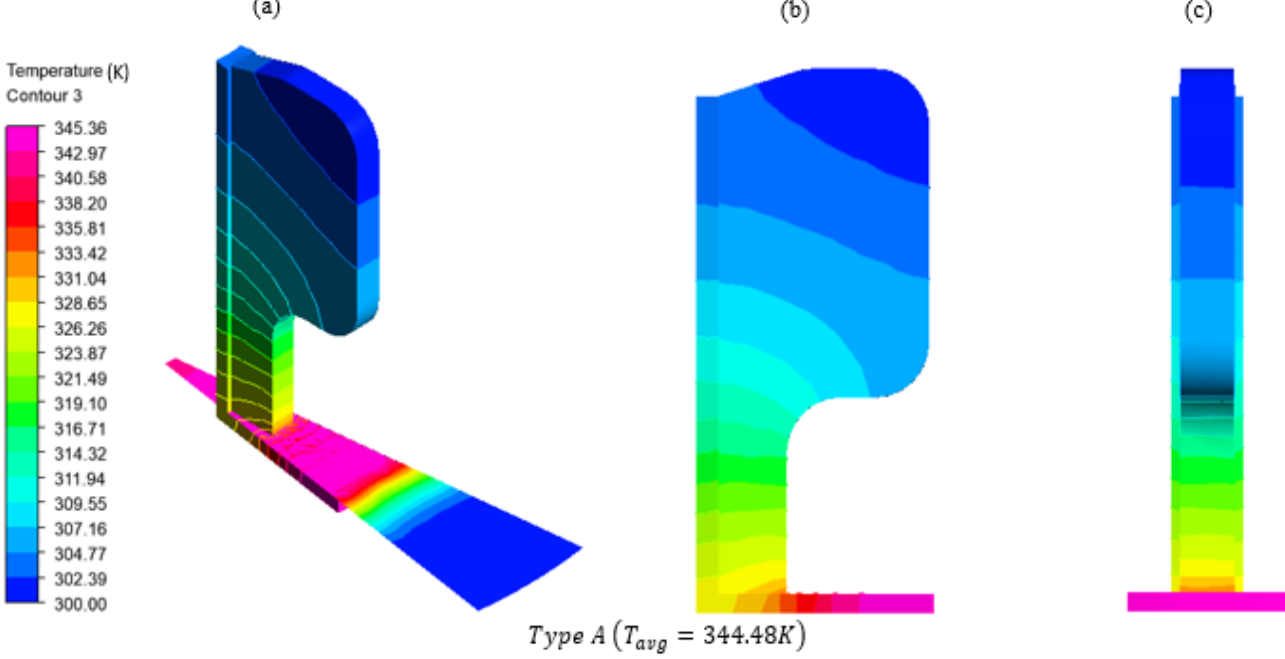
Figure 9: Temperature contour plot of the Type A radial HS at 𝑞̇ = 190 0 𝑊/𝑚 2 for (a) 3D view of Type A (b) Side view of Type A (c) Frontal view of Type